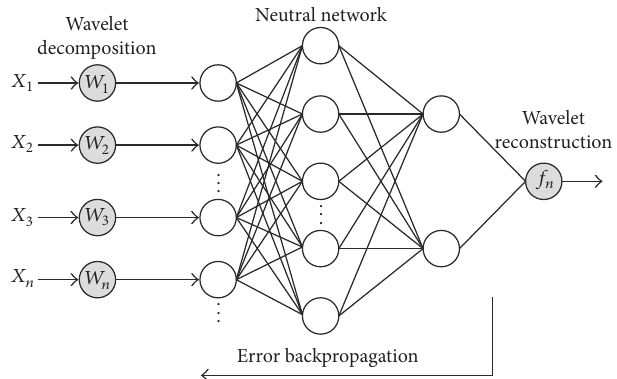
Figure 1: Wavelet neural network.